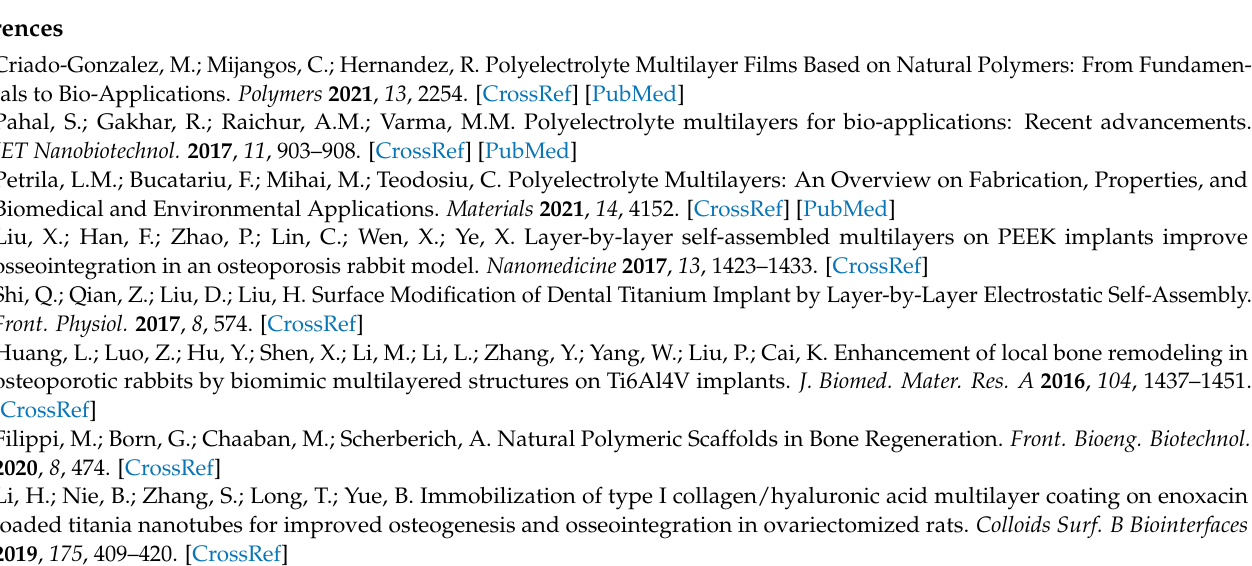
Figure S2: (a) Representative AFM images of all PEM coatings investigated in the manuscript and (b) summarizing data from the topographical analysis. Figure S3: Representative IR spectra of cross- linked film systems. Shown are peaks between 1800 and 1450 nm (Amid I between 1690–1620 cm − 1 and Amid II between 1590 and 1520 cm − 1 ). For better visualization, the graphs were normalized and the bottom line corrected. Thus, the shown graphs are not directly comparable with data in Figure 3, since the analysis was conducted with unprocessed data. Figure S4: Fluorescence microscope images from MC3T3 cells after performing an adhesion experiment on different PEM films without EDTA in the medium. Figure S5: Fluorescence microscope images from MC3T3 cells after performing an adhe- sion experiment on different PEM films with EDTA in the medium. Figure S6: Optical ellipsometry grey-scale images. Table S1: (a,b) Statistical analysis of the results from Figure 10. For the analysis an unpaired t -test with a normality test (Shapiro–Wilk test) was performed. As significance value the two-tailed p -value is shown. The calculation of the significance was conducted with SigmaPlot